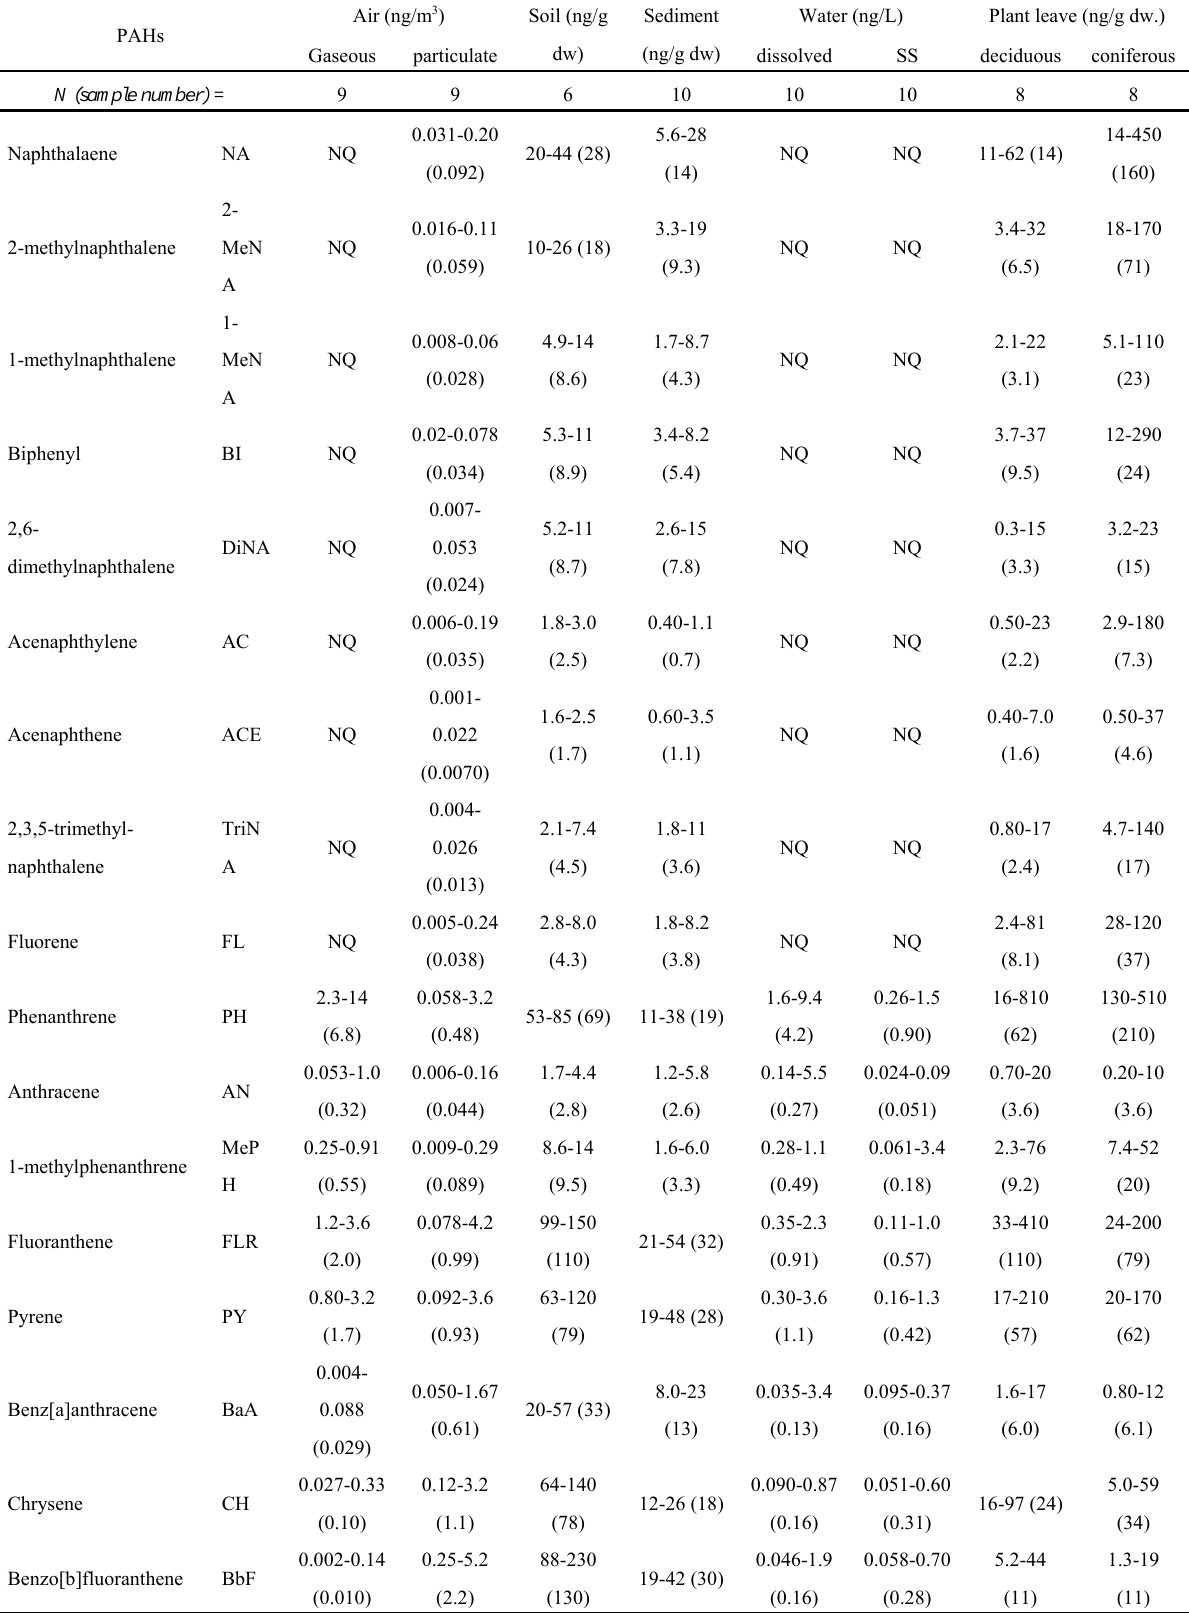
Table 2. Concentration range (median) of target PAH compounds measured for each medium at the two sites (urban and